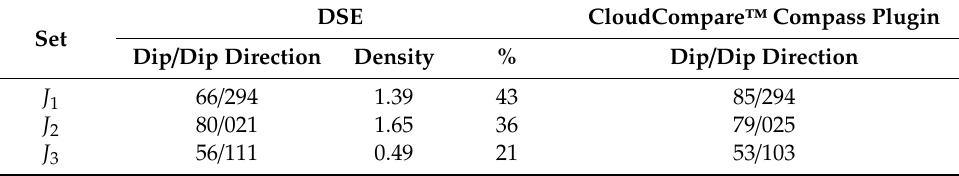
Table 3. Discontinuity sets and their characteristics in terms of dip and dip direction resulted from point cloud-based structural analysis.